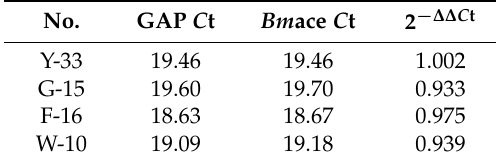
Table 1. q-PCR results of clones with similar relative copy number.